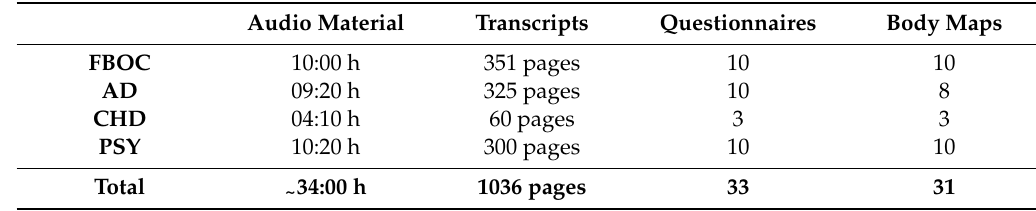
Table A5. Data material used for